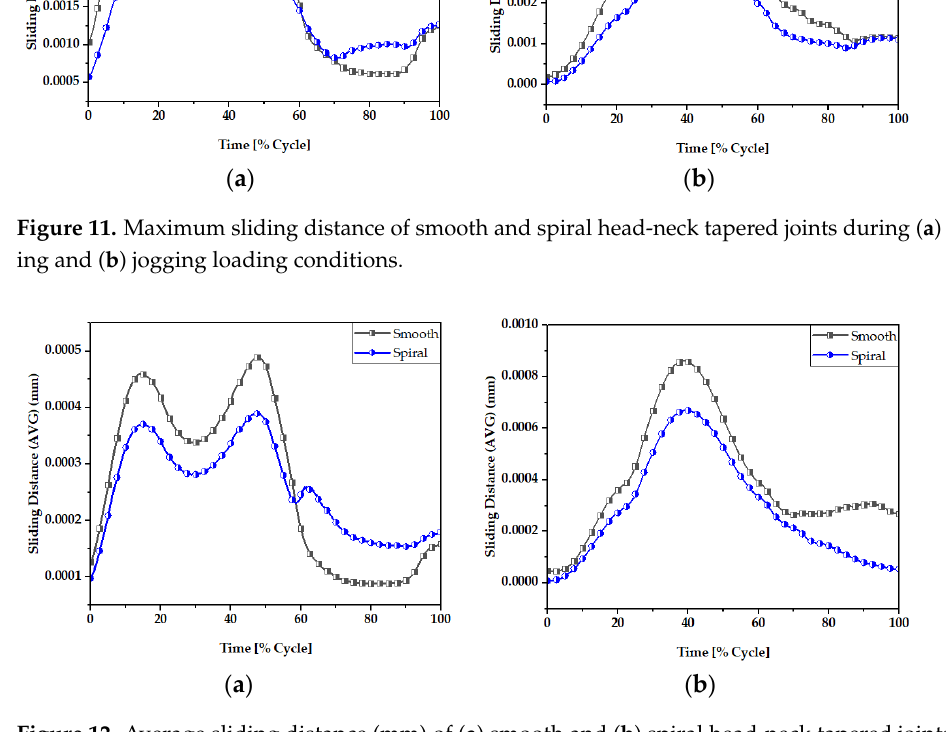
Figure 12. Average sliding distance (mm) of ( a ) smooth and ( b ) spiral head-neck tapered joints.